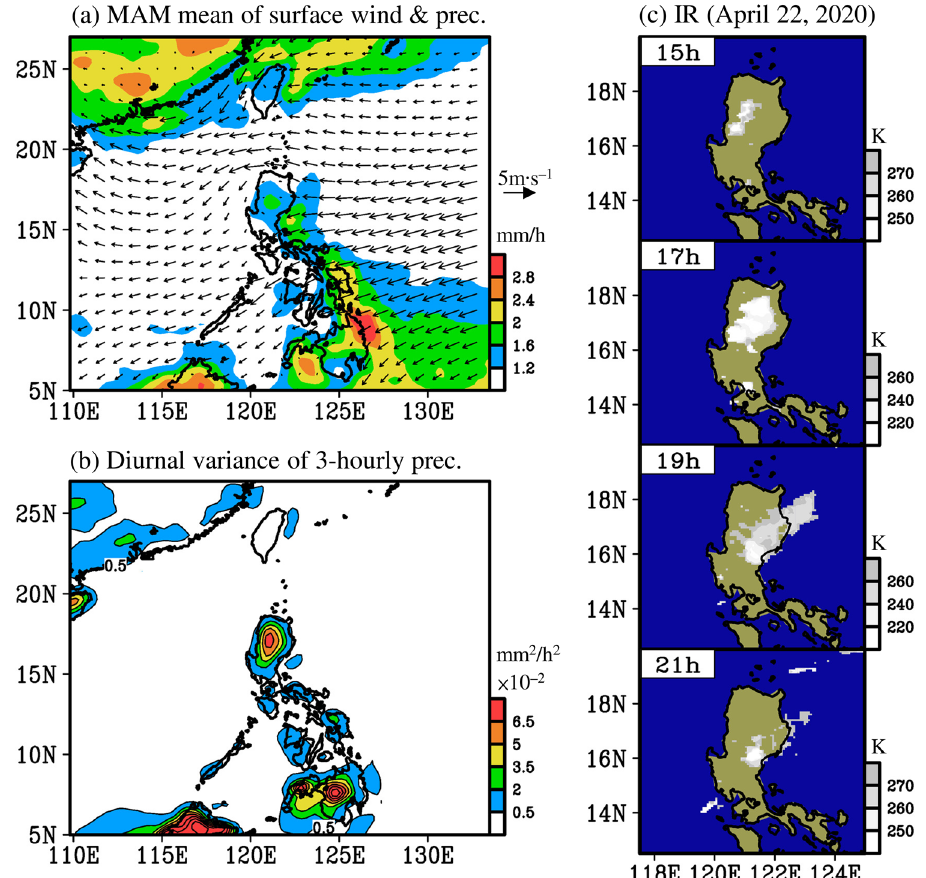
Figure 2. ( a ) Seasonal mean of surface wind (vectors) extracted from ERA5, superimposed with precipitation extracted from TRMM, and averaged for spring during 2001–2019 (March to May; MAM). ( b ) Diurnal variance of three-hourly precipitation estimated by TRMM, averaged during 2001–2019 spring. ( c ) Infrared satellite imagery for an eastward propagation of spring diurnal precipitation that occurred on April 22, 2020; the IR image is created from Gridded Satellite B1 observations ( available at https:// www. ncdc. noaa. gov/ grids at/). In ( c ), the times are given in local time. This figure is created using the software of GrADS